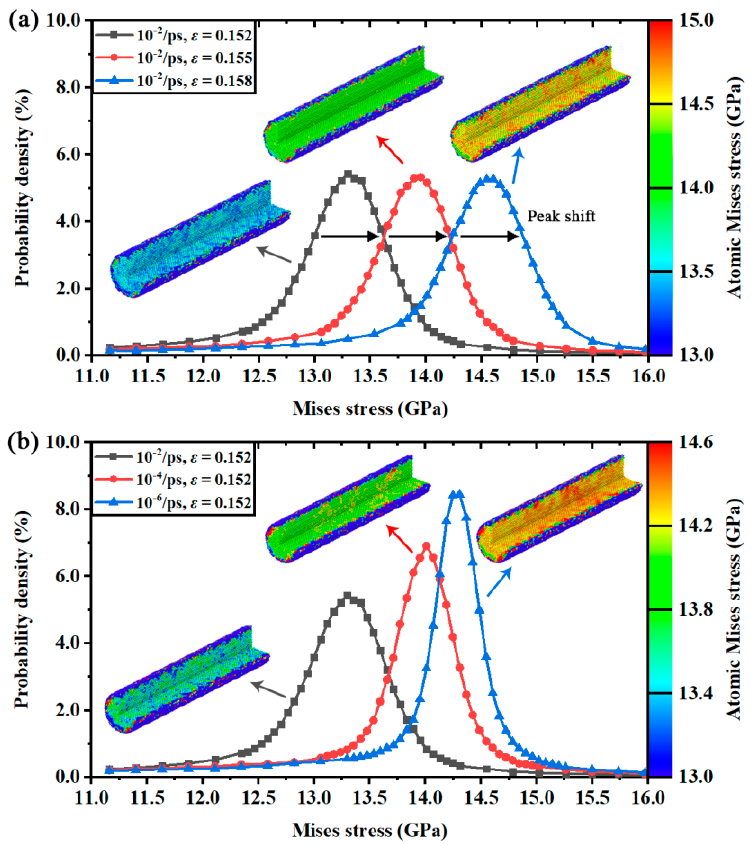
Figure 9. Probability density of von Mises stress distributions in SiNW: ( a ) at three different applied strains and equal strain rates; ( b ) at three different strain rates and equal applied strains.